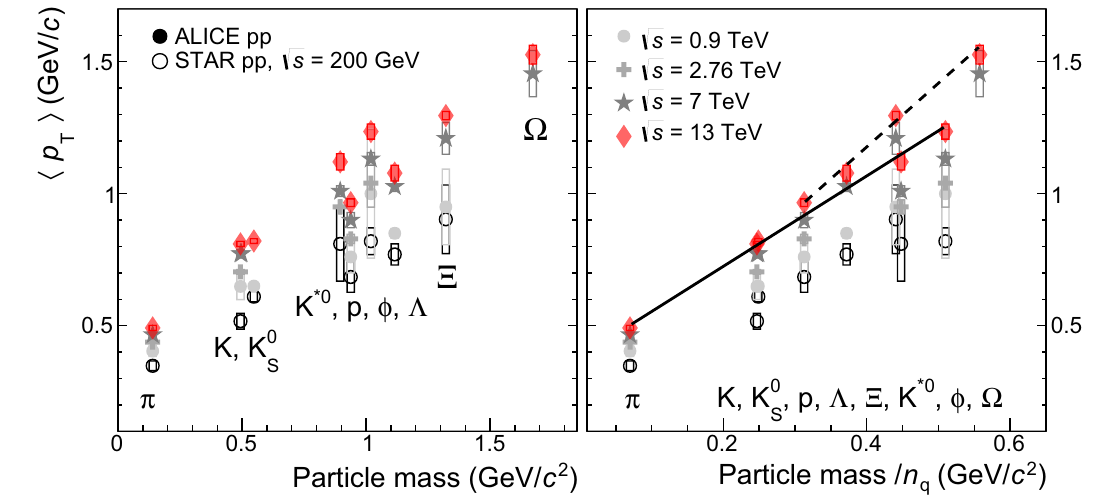
Fig. 12 Average transverse momenta of light-flavor hadrons as a func- tion of hadron mass (left) and as a function of hadron mass normal- ized to the number of constituent quarks (right) for different collision √ s ). Results reported from ALICE [7,24,26,27,51,58,63] energies ( are compared with those measured by STAR at RHIC at